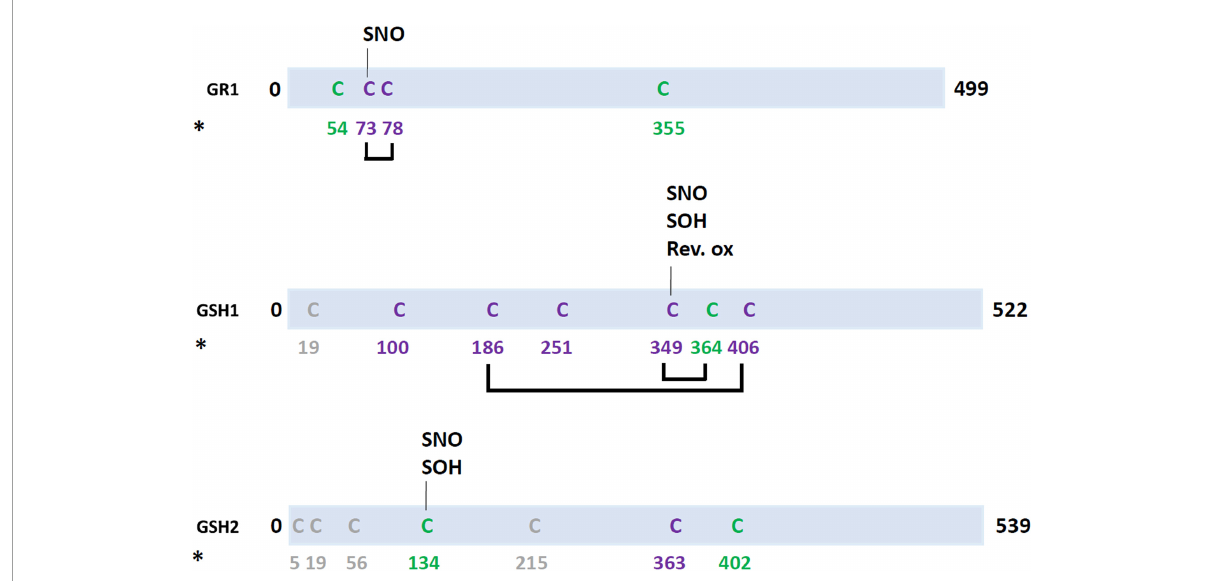
FIGURE3 Redox post-translational modifications of enzymes involved in glutathione biosynthesis pathway in the green lineage. In purple, cysteines conserved in all Arabidopsis isoforms and in at least one isoform from Chlamydomonas reinhardtii (green alga), Physcomitrella patens (Bryophyte), Selaginella moellendorffii (Lycophyte), Oryza sativa (Monocot), Zea mays (Monocot), Glycine max (Annual eudicot), Brassica oleracea (Biennal eudicot), Solanum lycopersicum (Perennial), Populus trichocarpa (Perennial), and Vitis vinifera (Perennial). In green, cysteines conserved in all Arabidopsis isoforms and at least one isoform from other terrestrial plants. In gray, cysteines present in A. thaliana isoform but not conserved in isoforms from other plants. For nitrosylation (SNO), reversible cysteine oxidation (Rev. ox.) and sulfenylation (SOH), targeted cysteines are known and they are indicated on the scheme. When targeted cysteines are unknown, the following code applies: ∗ ,